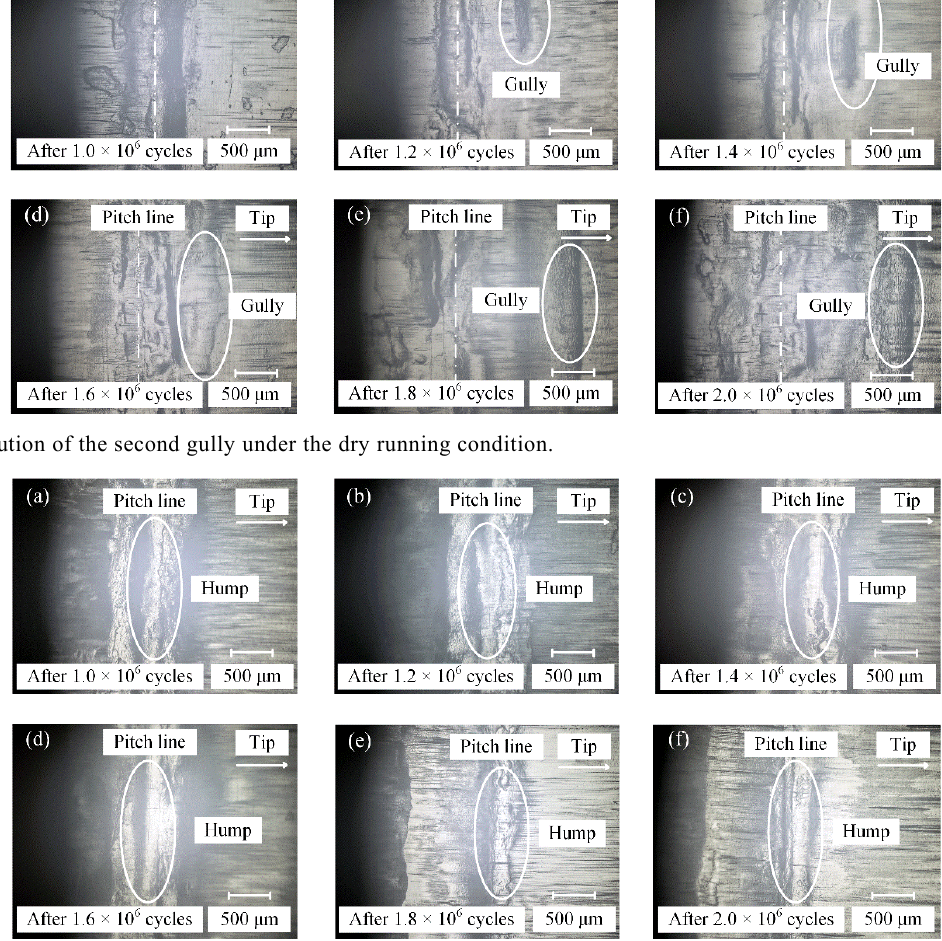
Fig. 12 Evolution of the hump under the dry running condition.